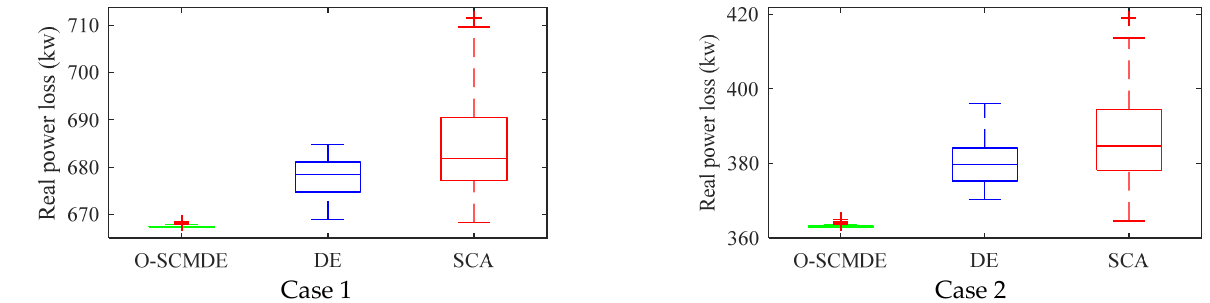
Figure 21. Box plot for scenario I of the 118 bus test system.